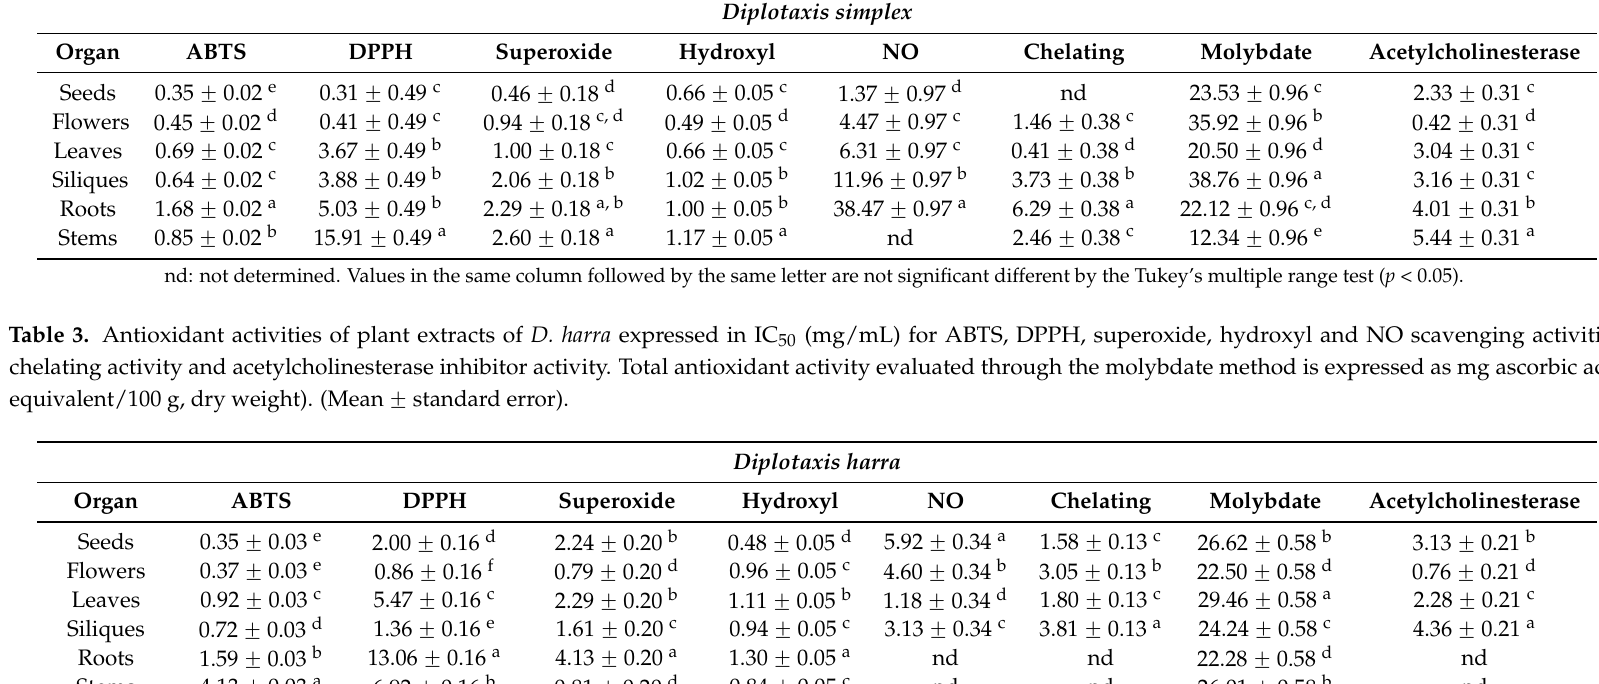
Table 2. Antioxidant activities of plant extracts of D. simplex expressed in IC 50 (mg/mL) for ABTS, DPPH, superoxide, hydroxyl and NO scavenging activities, chelating activity and acetylcholinesterase inhibitor activity. Total antioxidant activity evaluated through the molybdate method is expressed as mg ascorbic acid equivalent/100 g, dry weight). (Mean ˘ standard error).